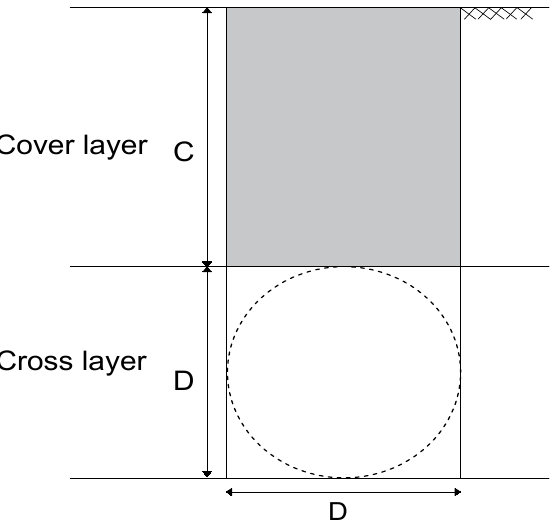
Figure 10. Model considering two layers of soil. Table 2. Soil parameters and tunnel geometry (soil with two